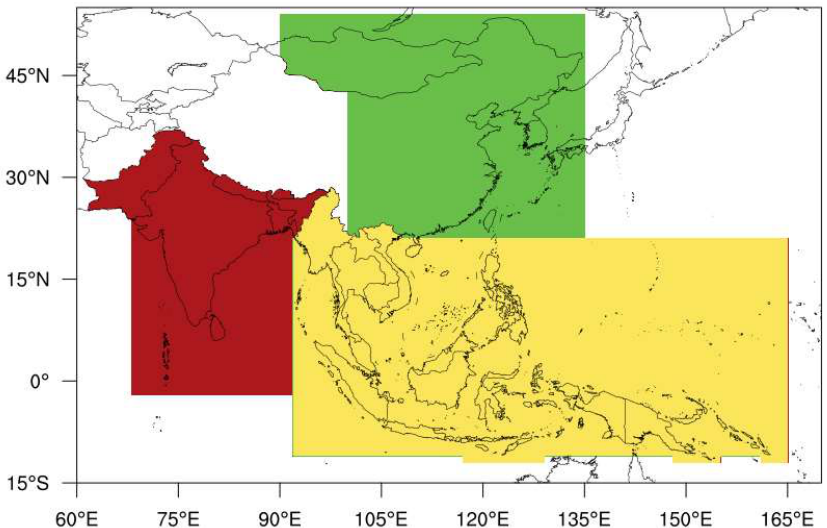
Figure 2. Division of the experimental area. The red shades represent South Asia. The green shades represent East Asia. The yellow shades represent Southeast Asia.